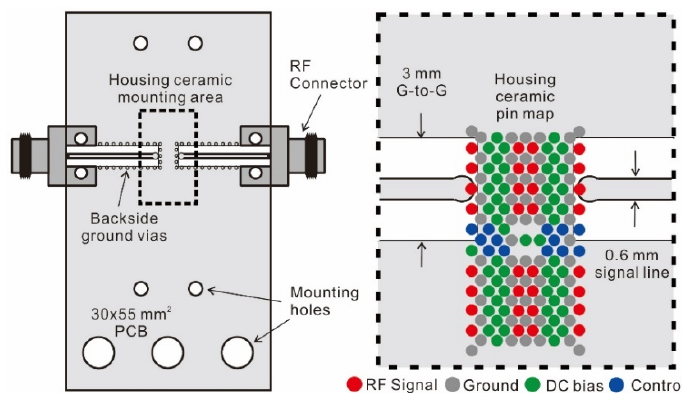
Figure 3. ( a ) Loss-estimation PCB and ( b ) the measured and simulated losses